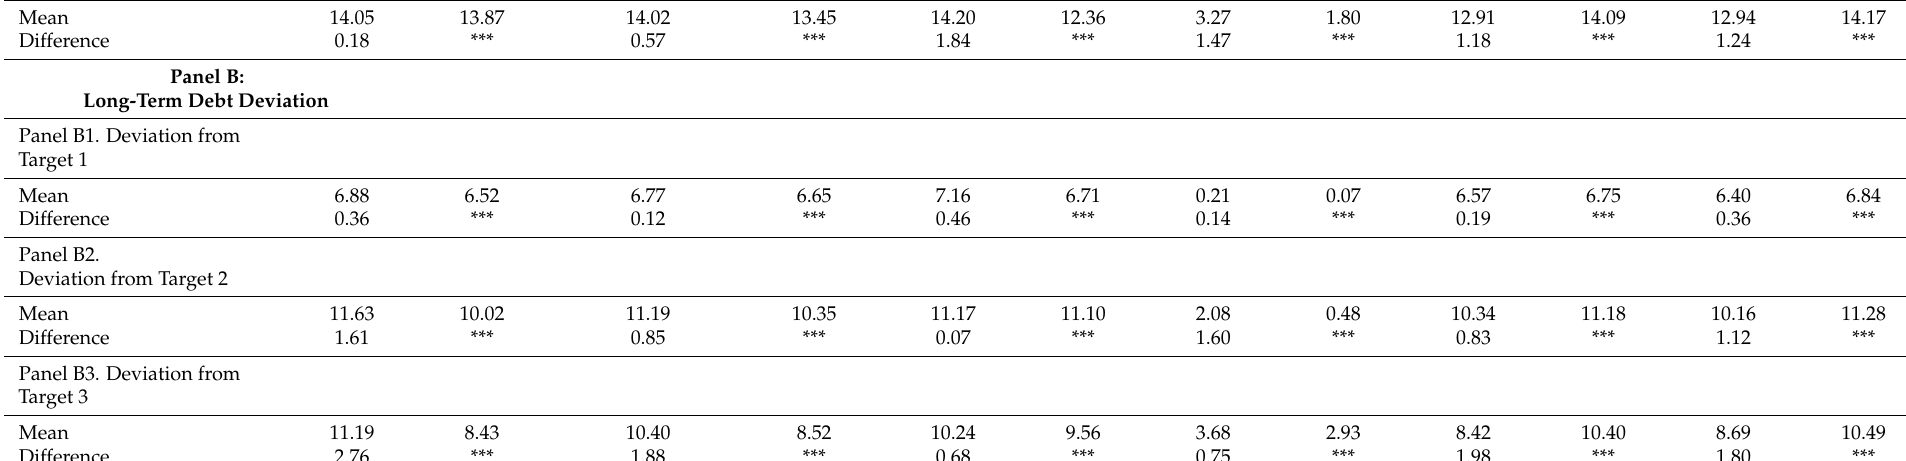
Panel A3. Deviation from Target 3